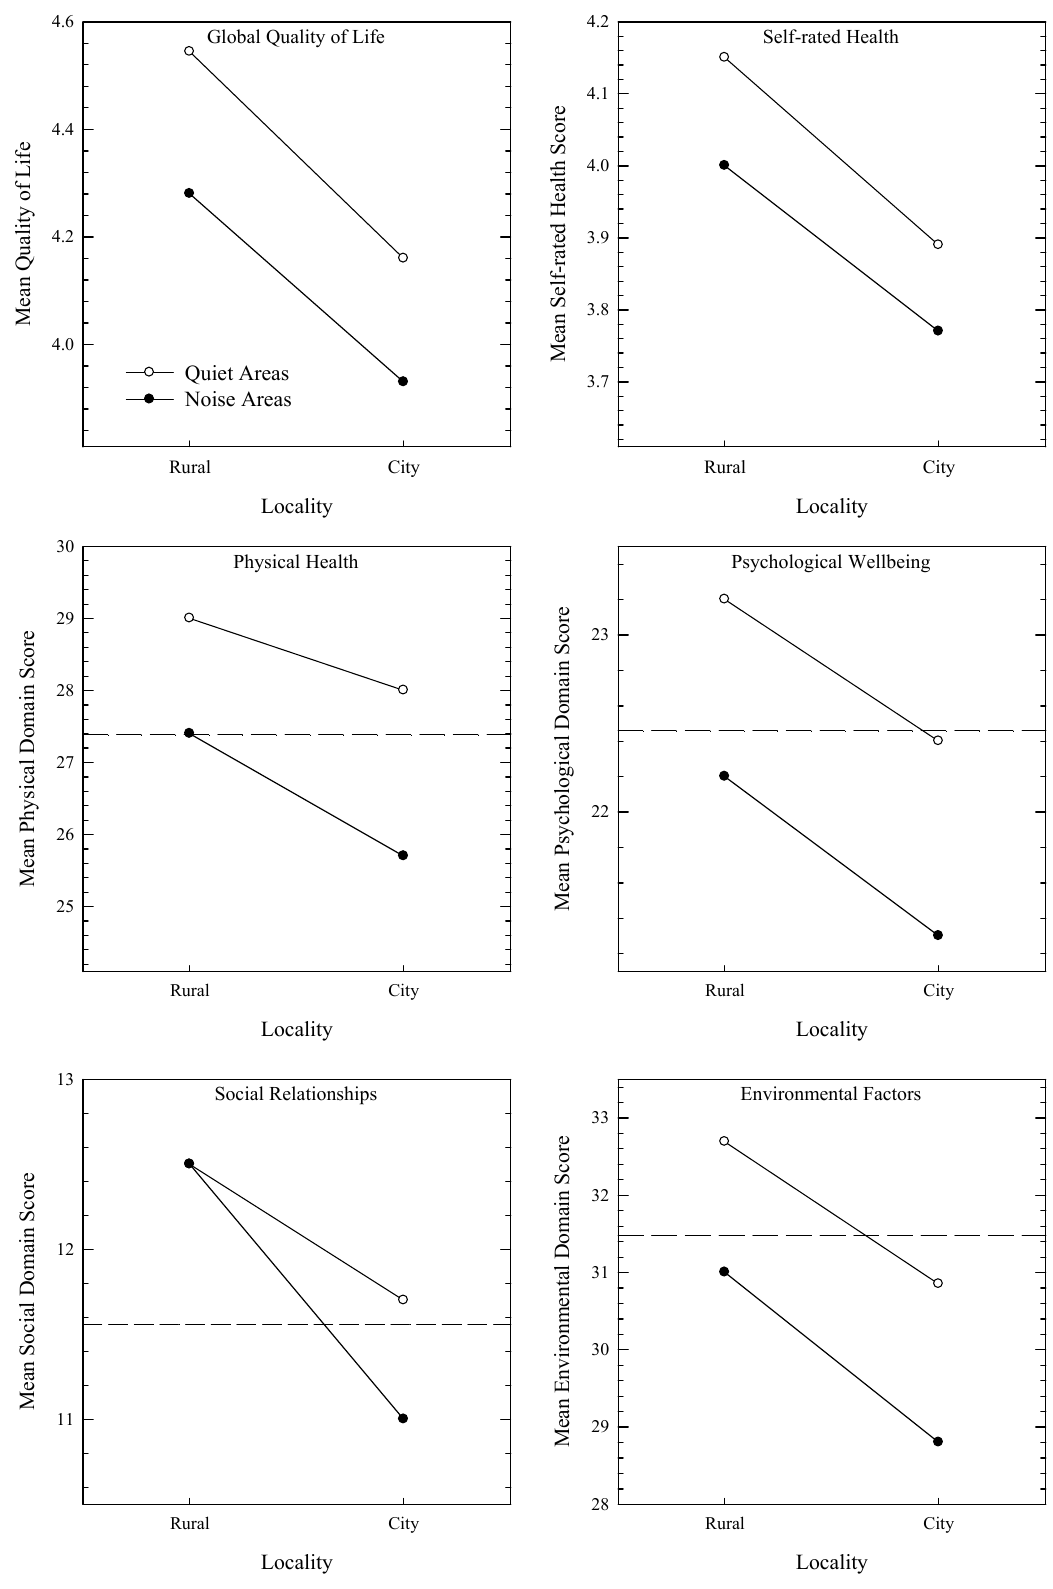
Figure 6. Health-related quality of life (WHOQOL) scores as a function of locality (rural versus city) and quiet (open symbols) or noisy (closed symbols) classification. The dashed-horizontal lines contained within the plots of the four WHOQOL-BREF domains represent national means calculated from a New Zealand normative